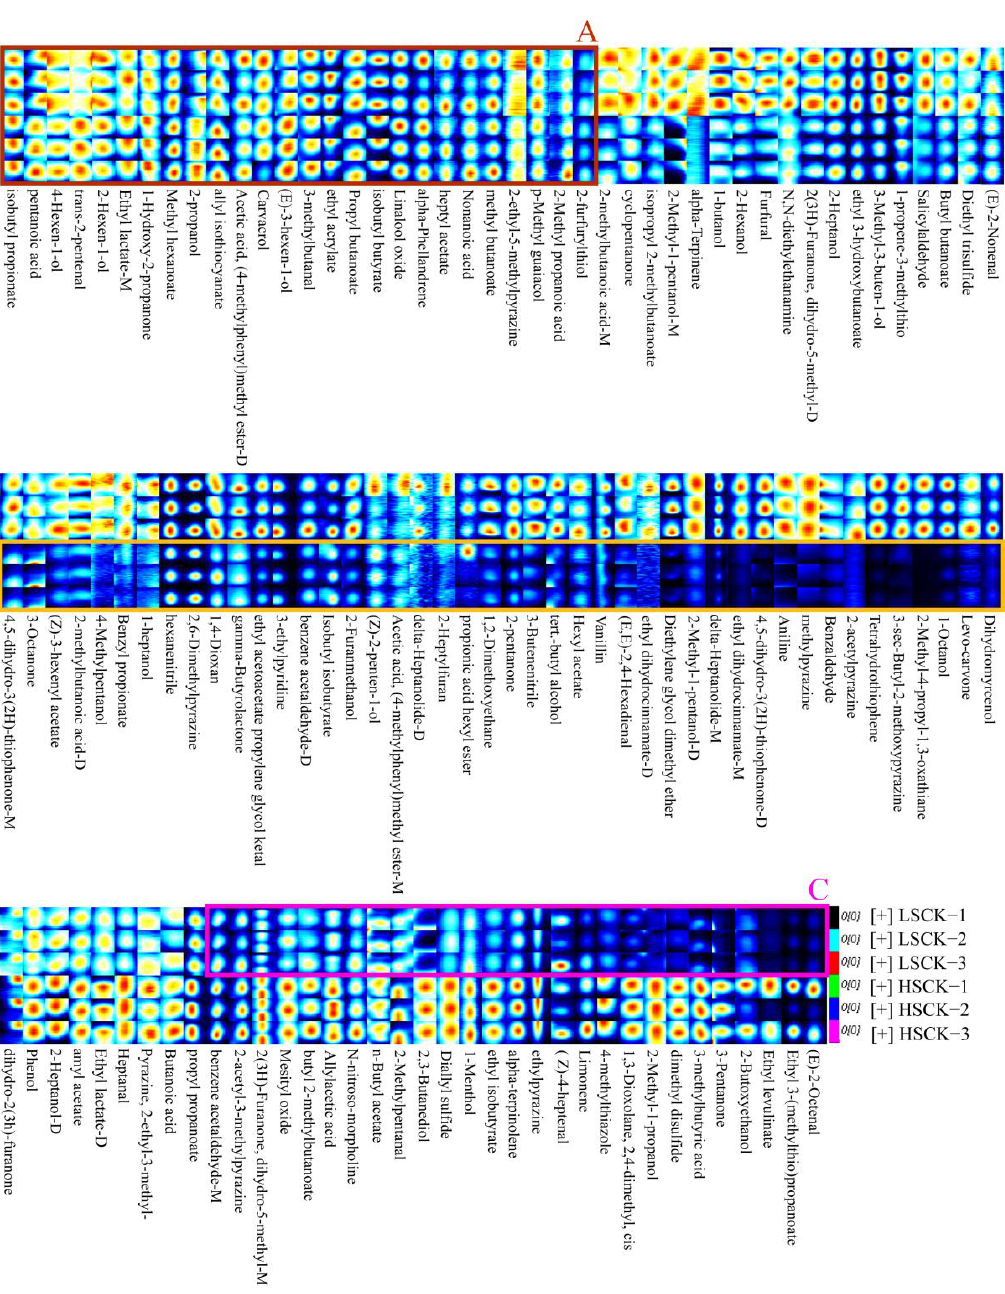
Figure 3. The fingerprint profiles of the labelled peaks for volatile flavor substances from LSCK and HSCK. LSCK-1, LSCK-2, and LSCK-3 indicated the three parallel experiments for LSCK. Similarly, HSCK-1, HSCK-2, and HSCK-3 indicated the three parallel experiments for HSCK. To further demonstrate the differences in volatile flavor substances between LSCK and HSCK, the PCA and OPLS-DA were employed, as shown in Figure 4. The scatter plots for PCA and OPLS-DA of LSCK and HSCK distributed well, suggesting that the differ- ences in volatile flavor substances between LSCK and HSCK were significantly different [18], which agreed well with the GC-IMS results. The quality parameters of the PCA and OPLS-DA model are shown in Tables 2 and 3.